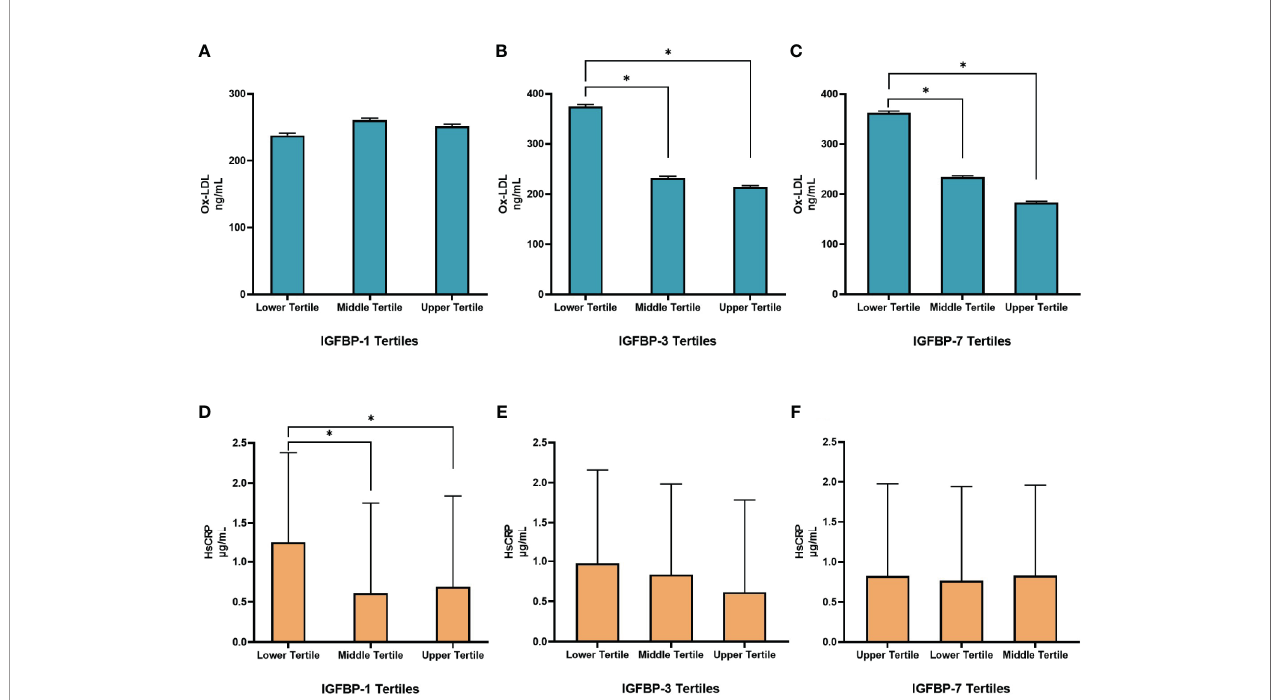
FIGURE 3 | Distribution of Ox-LDL (A – C) and Hs-CRP (D – F) in different tertiles of IGFBPs. (A) Levels of Ox-LDL across the three tertiles of IGFBP-1 were not signi fi cantly different. (B, C) The levels of Ox-LDL were signi fi cantly higher in the lower tertiles of IGFBP-3 and IGFBP-7 compared to the middle and higher tertiles, no differences were observed between Ox-LDL levels in the middle and upper tertiles. (D) Levels of Hs-CRP were signi fi cantly higher in the lower tertile of IGFBP-1 compared to the middle and upper tertiles but were not different between the middle and upper tertiles. (E, F) Levels of Hs-CRP across the three tertiles of IGFBP-3 and IGFBP-7 were not signi fi cantly different. N=144 in each group. Data is presented as geometric means ± SD. *p < 0.01 by one way ANOVA with Bonferroni post- hoc